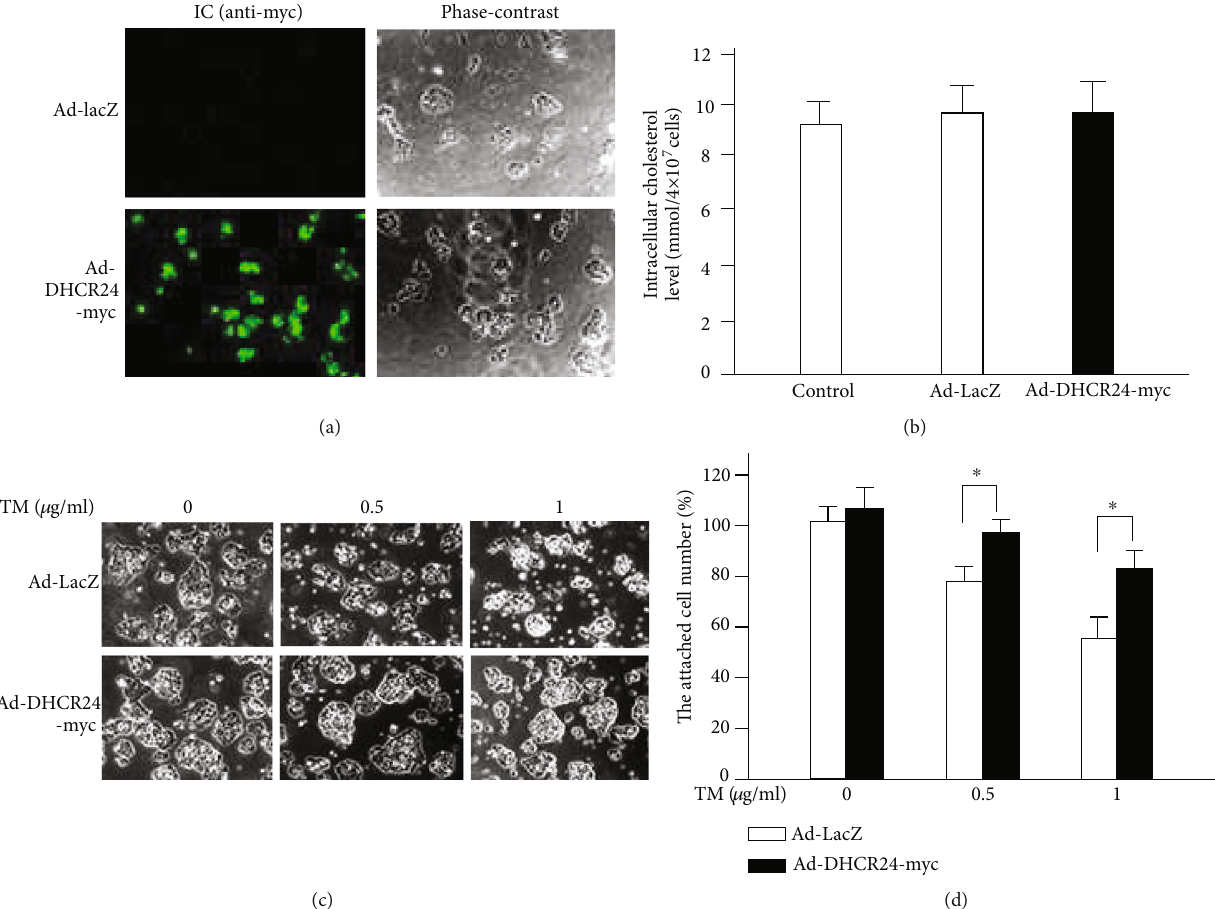
Figure 1: DHCR24 overexpression protects MIN6 cells from cell death caused by TM exposure. (a) Immunocytochemical (IC) analysis against c-myc (green fl uorescent signal) was used to determine the transduction e ffi ciency of Ad-DHCR24-myc. Scale bar, 100 μ m. (b) Sterol contents in MIN6 cells were measured 48 h after infection with the indicated adenoviruses (50 PFU/cell). Mean ± S : D : ( n = 3 ). (c) Images of MIN6 cells were acquired with a phase-contrast microscope 24 h after TM exposure (0, 0.5, and 1 μ g/ml). Scale bar, 100 μ m. (d) Numbers of adherent cells are expressed as percentage of cells in the Ad-LacZ group at 0 μ g/ml TM exposure. Mean ± S : D : ( n = 3 ); ∗ p < 0 : 05 vs.